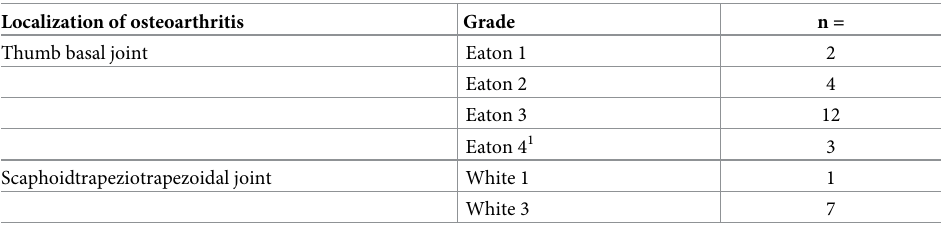
Table 1. Localization and grading of the